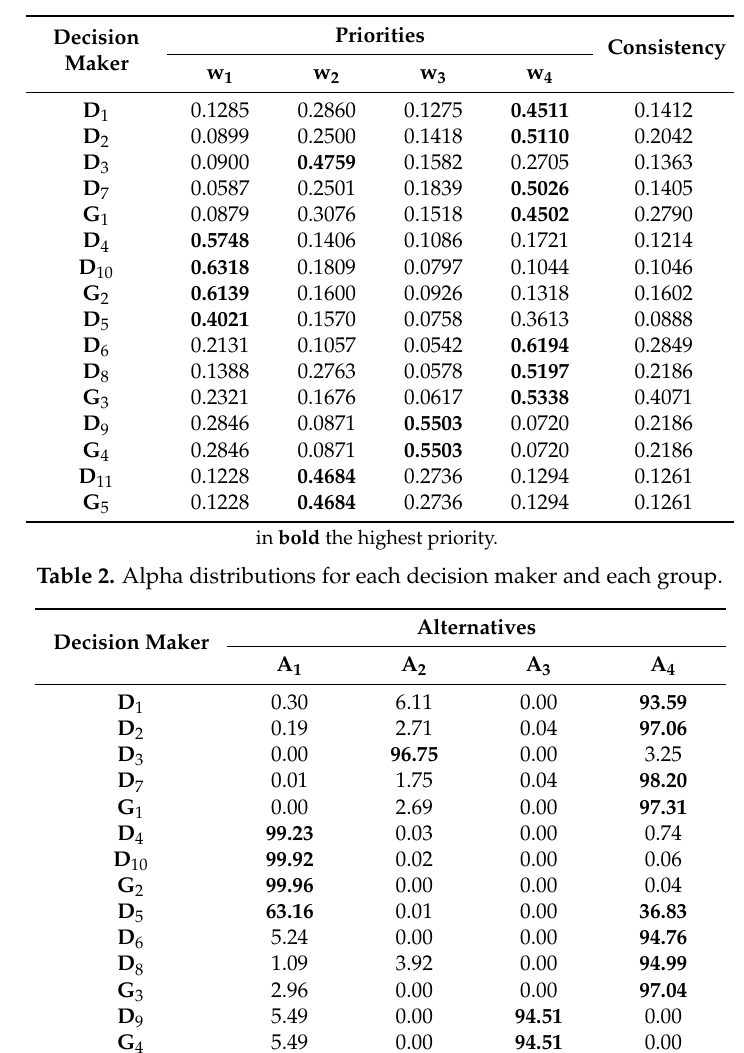
Table 1. Priorities and consistency for each decision maker and each group.